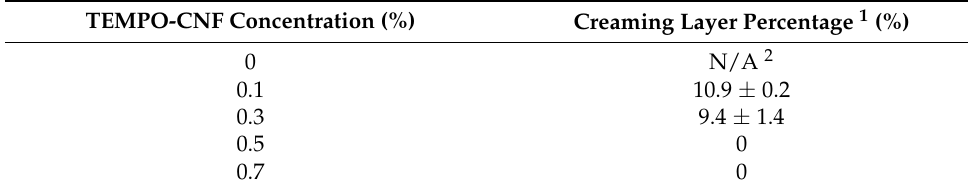
Table 3. Creaming layer percentage of emulsions stabilized by TEMPO-CNF after 24 h of storage at room